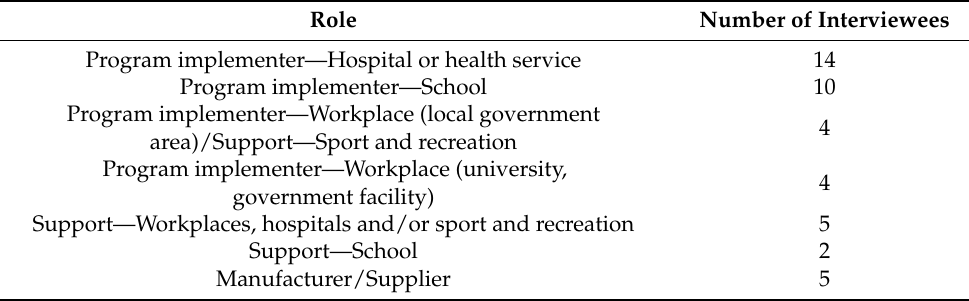
Table 2. Number of participants by role in guideline